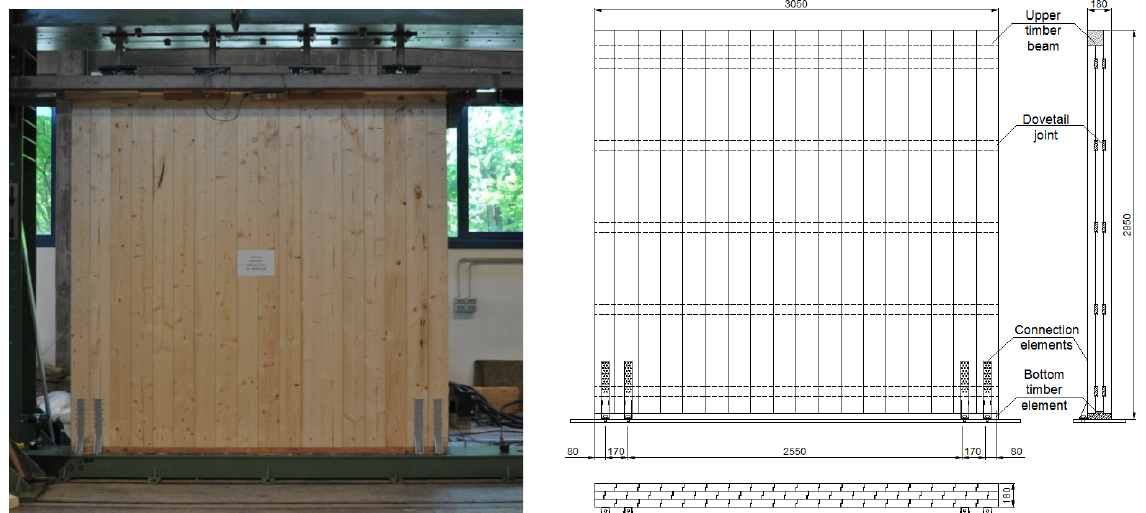
Figure 4. Wall C: Geometric